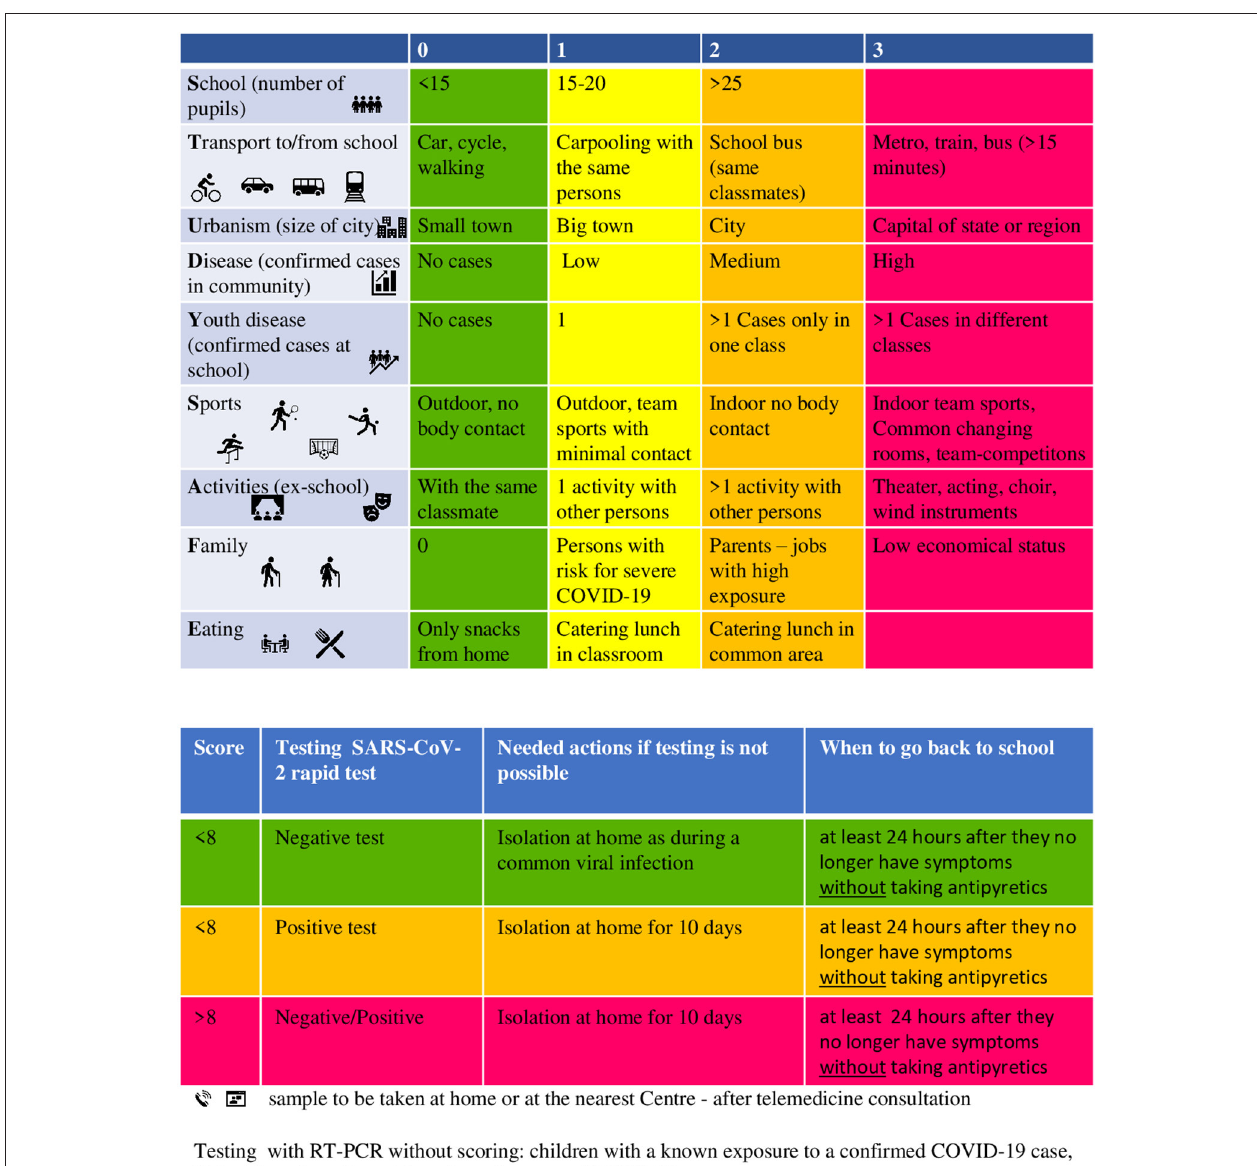
FIGURE 1 | COVID-19 score “STUDY SAFE” for testing low-risk school-age children with symptoms compatible with COVID-19.